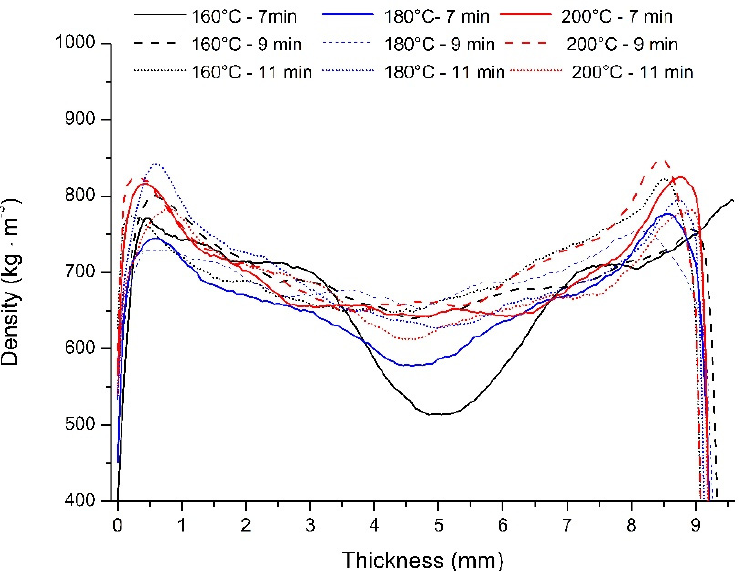
Figure 4. Density profile for particleboards manufactured at different pressing times (7, 9, 11 min)